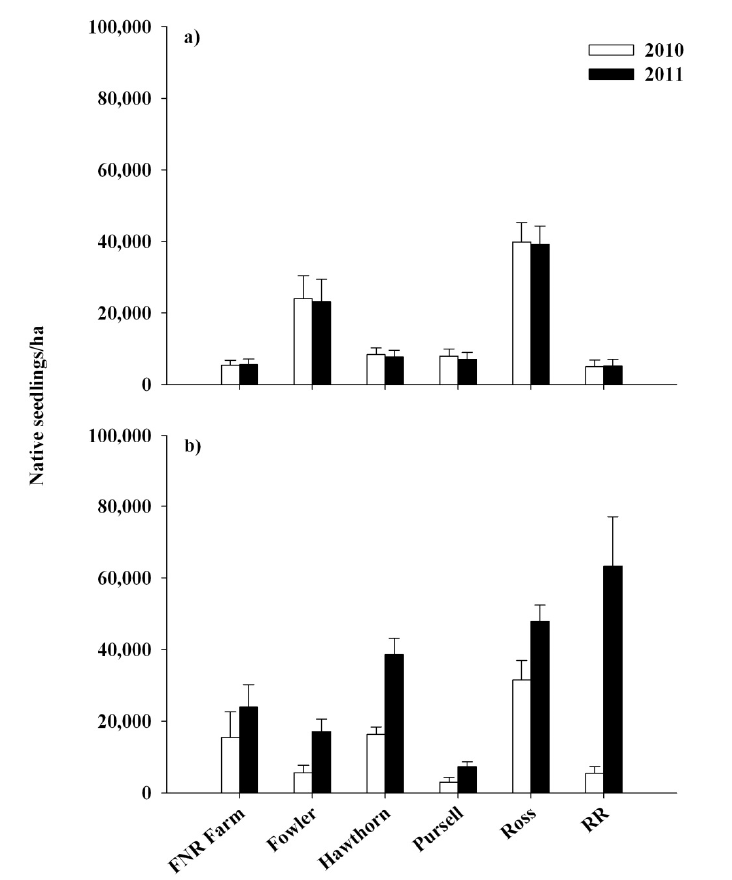
Figure 5. Mean (±1 SE) densities (stems/ha) of native seedlings (woody stems < 1.37 m tall) in reference ( a ) and removal areas ( b ), in 2010 and 2011, at six mixed-hardwood forests in central